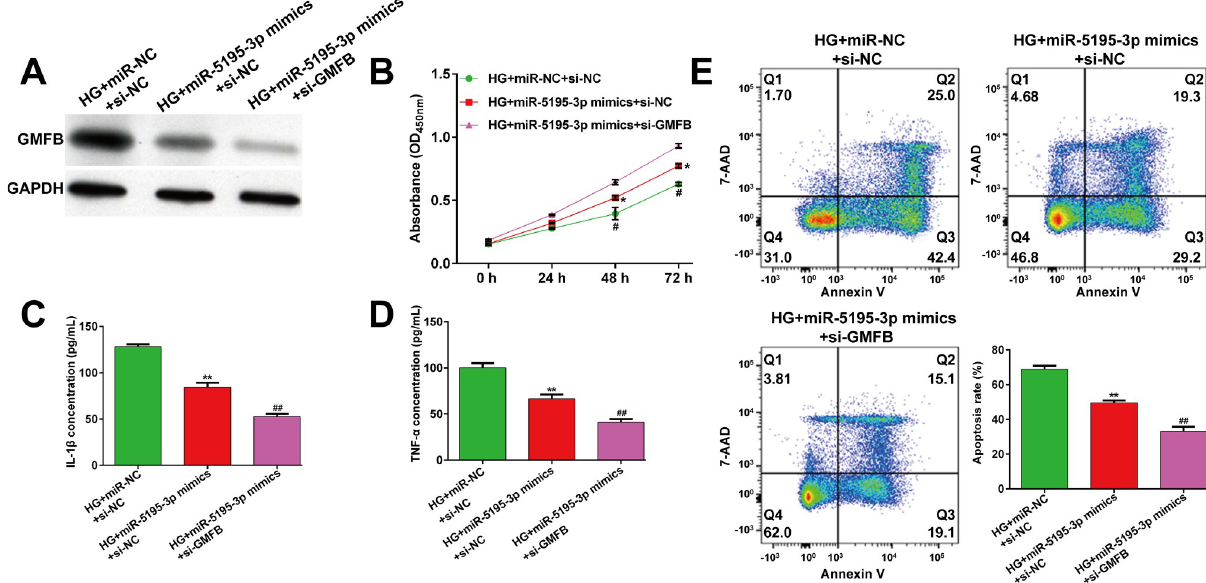
Fig 5. Knockdown of GMFB enhanced the protective effects of miR-5195-3p overexpression against HG-induced ARPE-19 cell injury. ARPE-19 cells were co-transfected with miR-5195-3p mimics and si-GMFB or si-NC, and then treated with HG for 24 h. (A) The protein expression of GMFB was detected by western blot analysis. (B) Cell viability was analyzed using CCK-8 assay. (C-D) ELISA assay was performed to analyze the release of IL- 1 β and TNF- α in transfected ARPE-19 cells, followed by HG stimulation. (E) The percentages of apoptotic cells were compared in transfected ARPE-19 cells, followed by HG stimulation. Data were shown as mean ± SD. � p < 0.05, �� p < 0.01, compared with HG + miR-NC + si-NC; # p < 0.05, ## p < 0.01, compared with HG + miR-5195-3p mimics + si-NC; NC, negative control; HG, high glucose; si, small interfering.